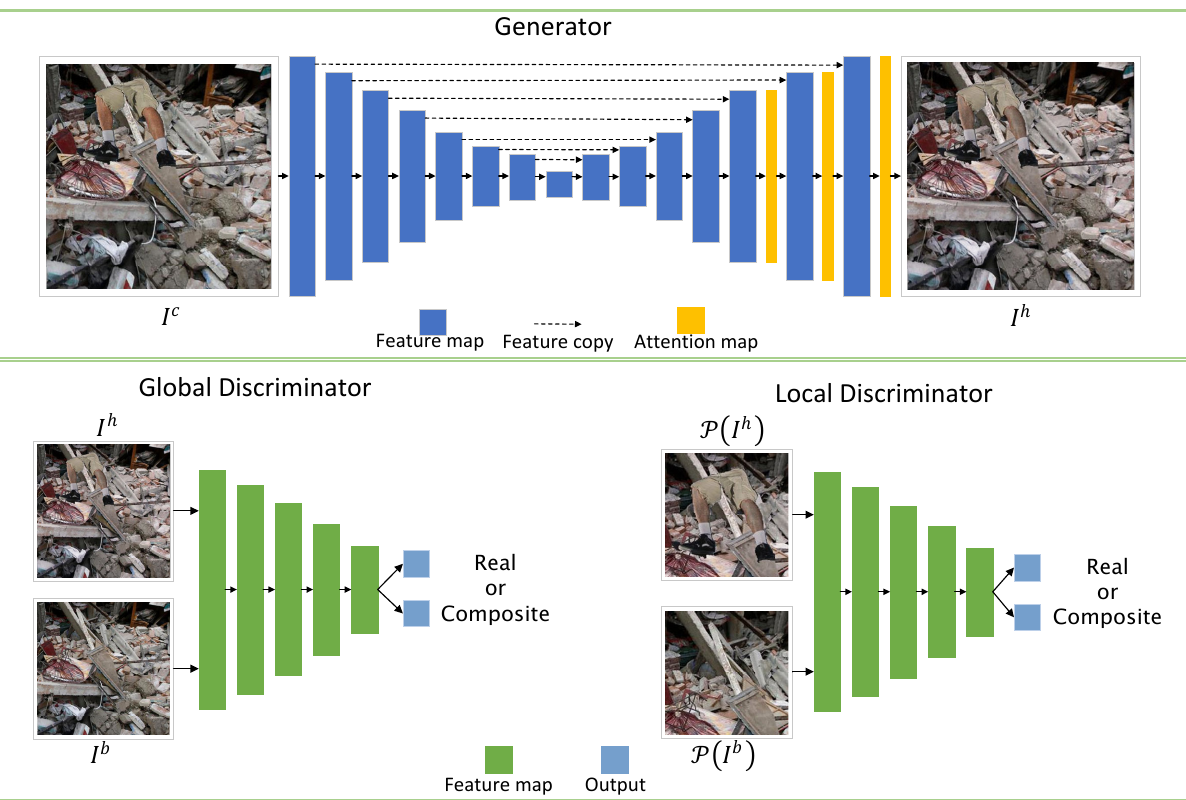
Figure 3. Our framework consists of a generator G and two five-layers discriminators D global , D local . The generator takes a composite image as input, and generates a harmonious image. Two discriminators discriminate the real images and the generated harmonious images globally and locally,